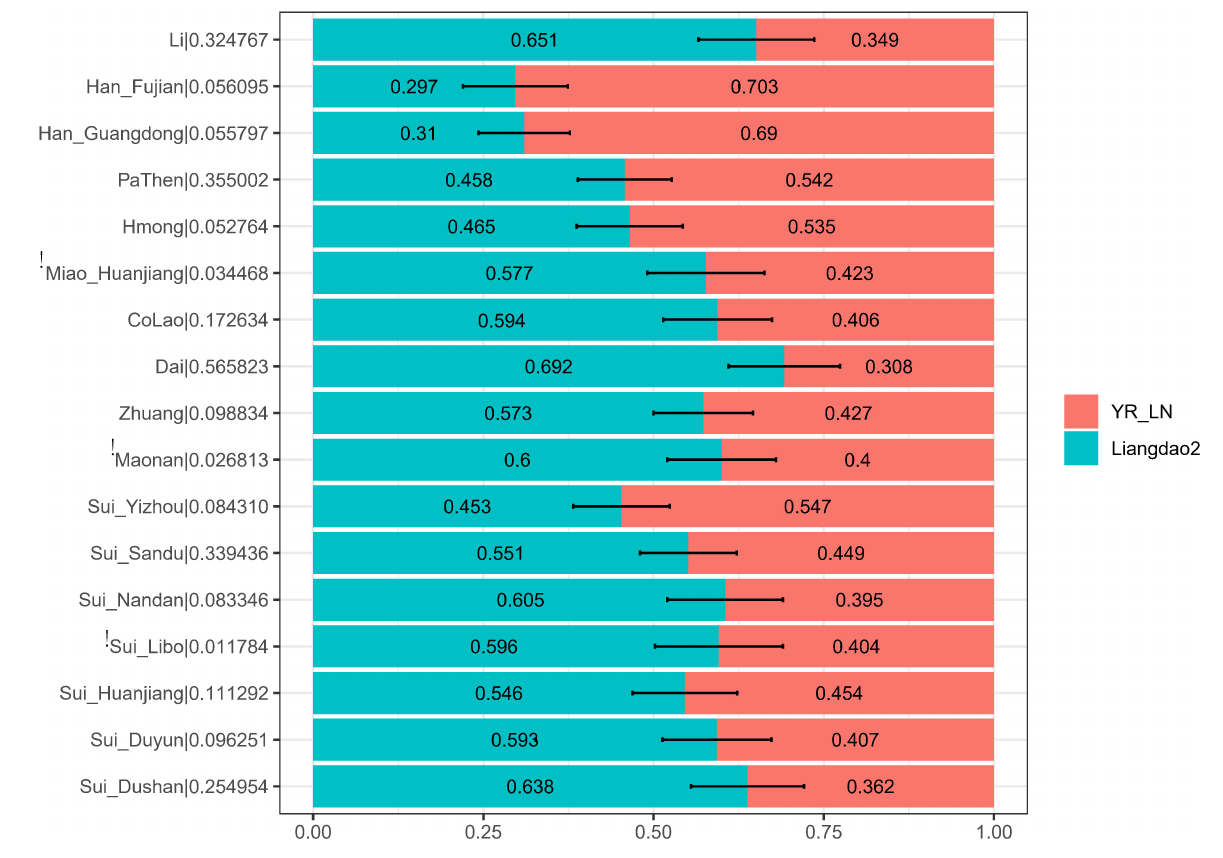
corrected p -value < 0.05 in Supplementary Figure 5 .